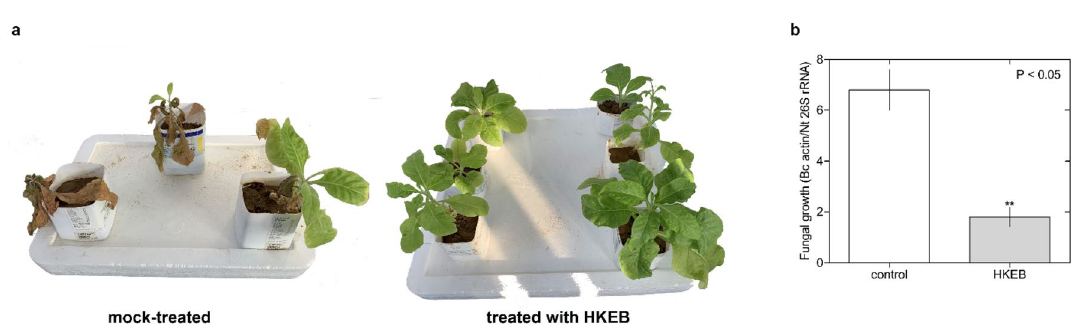
Figure 4. Time course of gene expression in Arabidopsis plants treated B. aryabhattai HKEB. The PDF1.2 ( a ), PR1 ( b ) and PAD3 ( c ) genes involved in plant defense were evaluated in Arabidopsis. The bars represent the mean values and standard errors of the means (n = 9). The experiments were replicated three times.